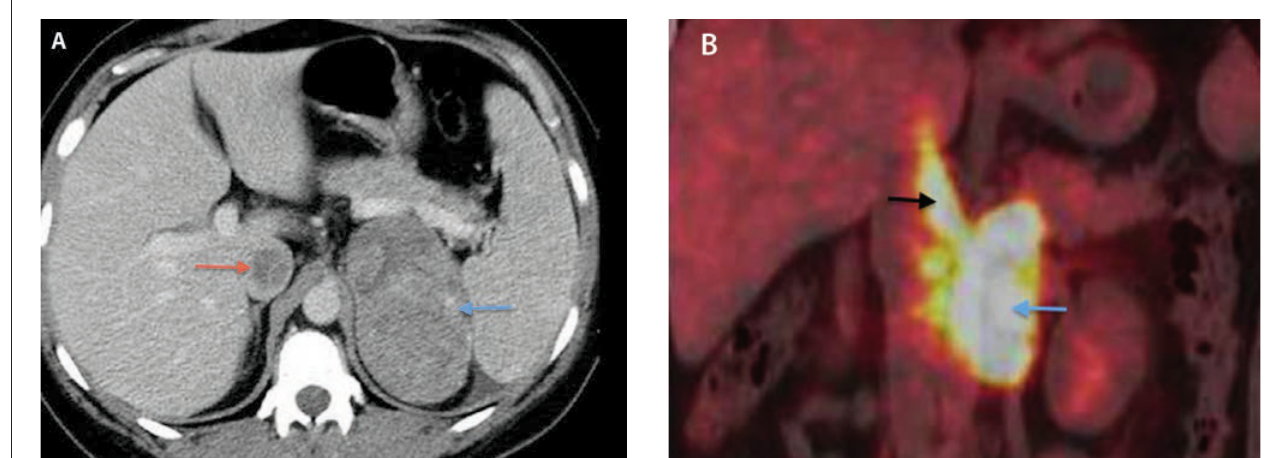
Fig. 5. Histologically proven adrenocortical carcinoma. (A) Axial enhanced CT image demonstrating a large heterogeneous left adrenal mass (blue arrow) with IVC invasion (red arrow). (B) Coronal PET image showing marked FDG activity in the left adrenal tumour (blue arrow) and within the IVC tumour thrombus (black arrow). (By courtesy of Dr I Francis)